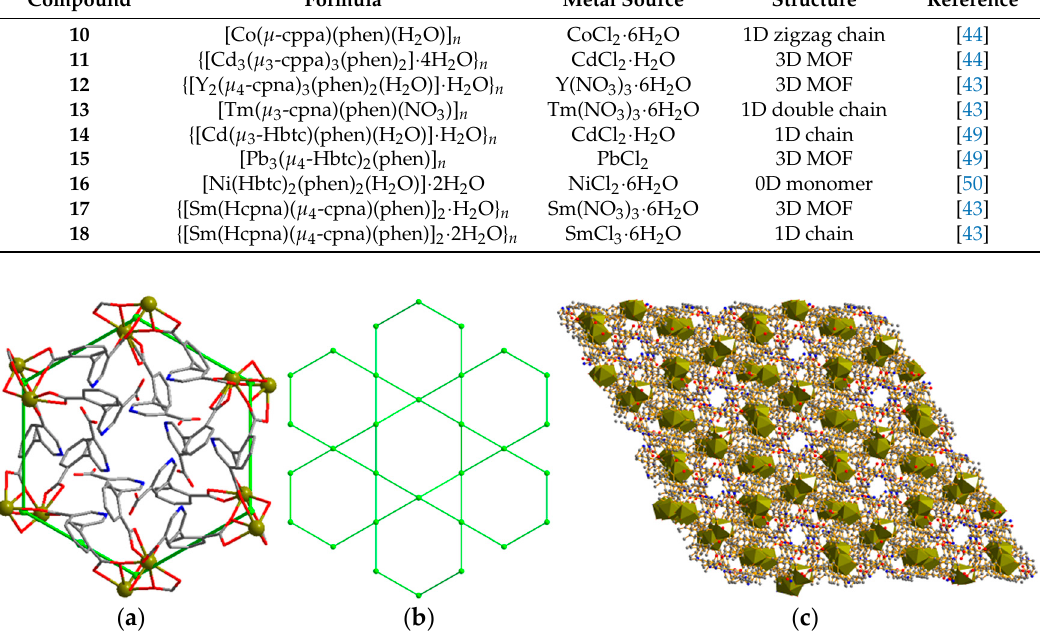
Table 2. Selected examples of CPs showing an effect of metal source on product structure. Compound Formula Metal Source